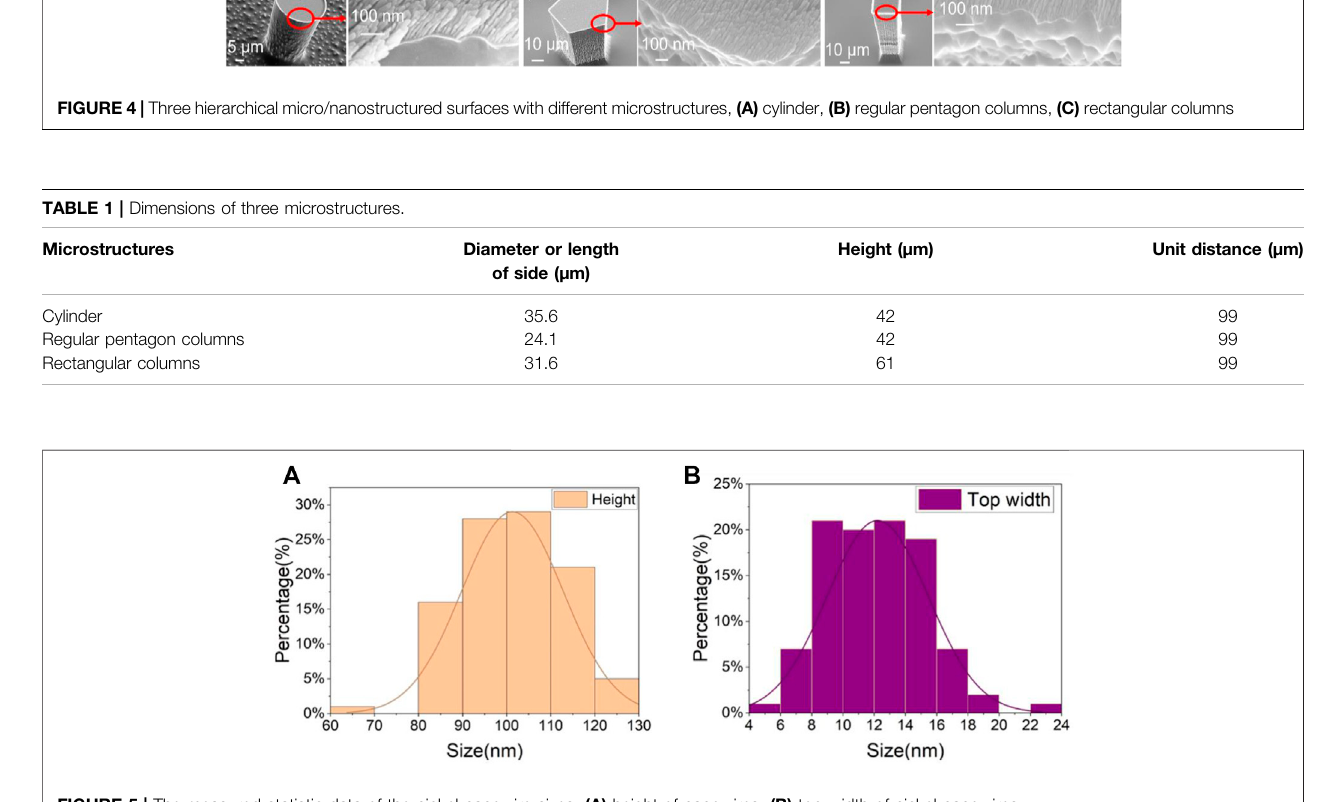
Frontiers in Bioengineering and Biotechnology |